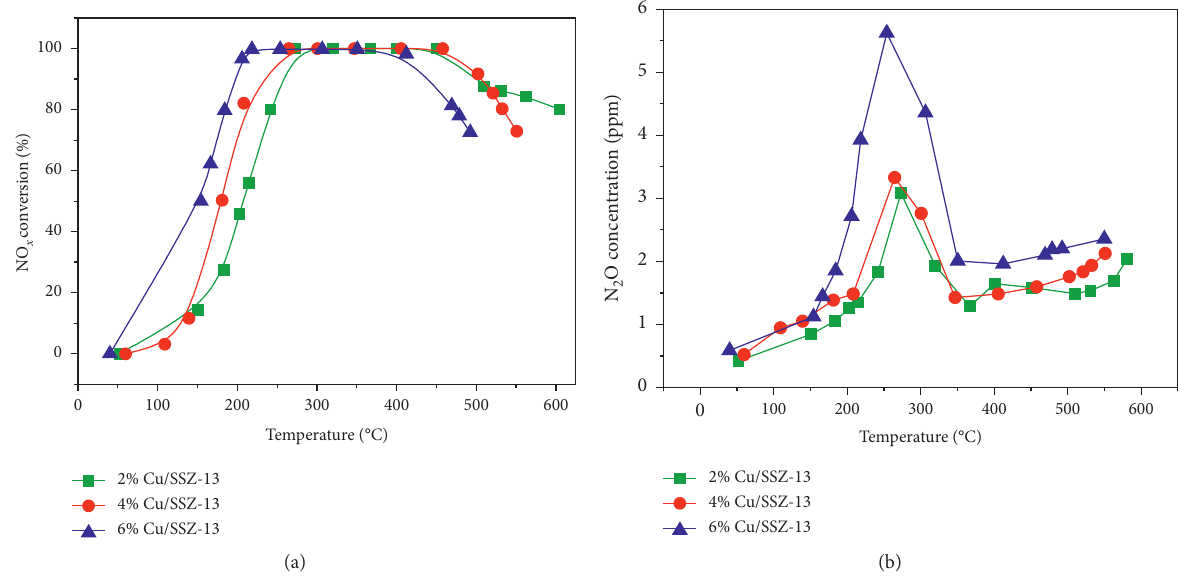
Figure 7: (a) SCR activity of the catalysts; (b) N